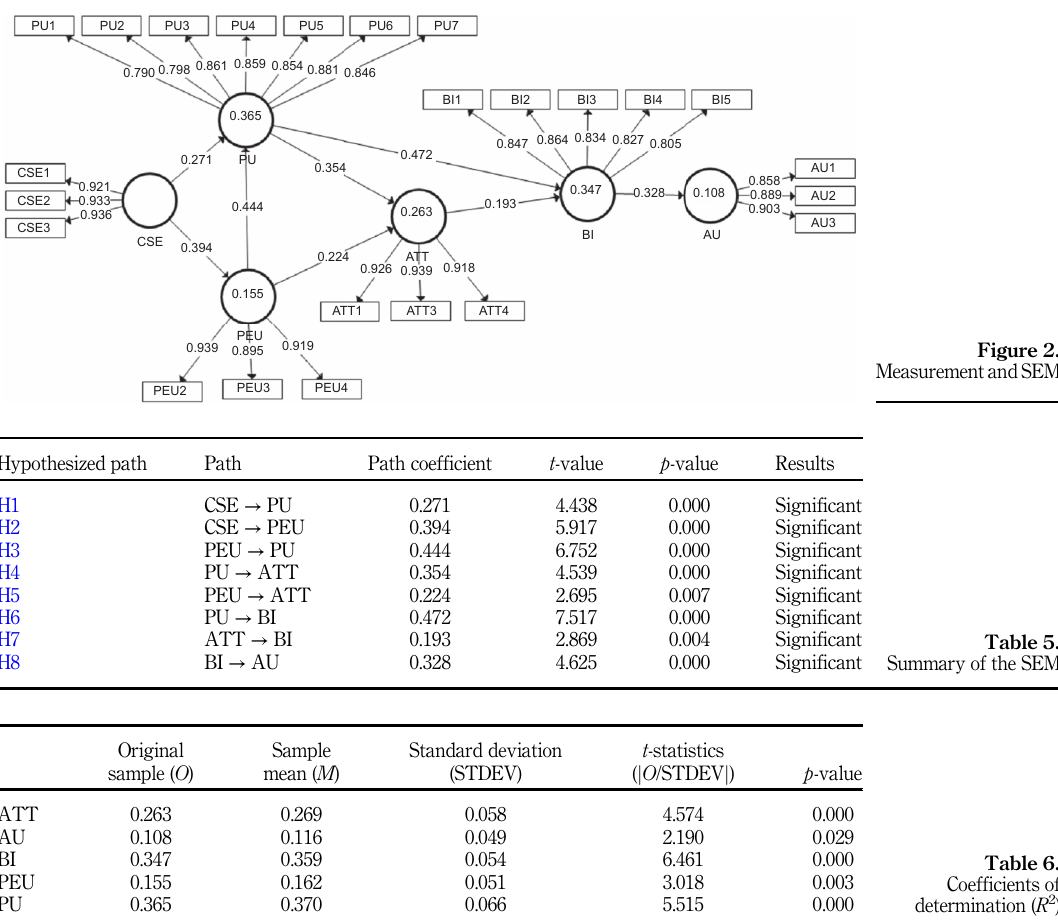
Table 5. Summary of the SEM